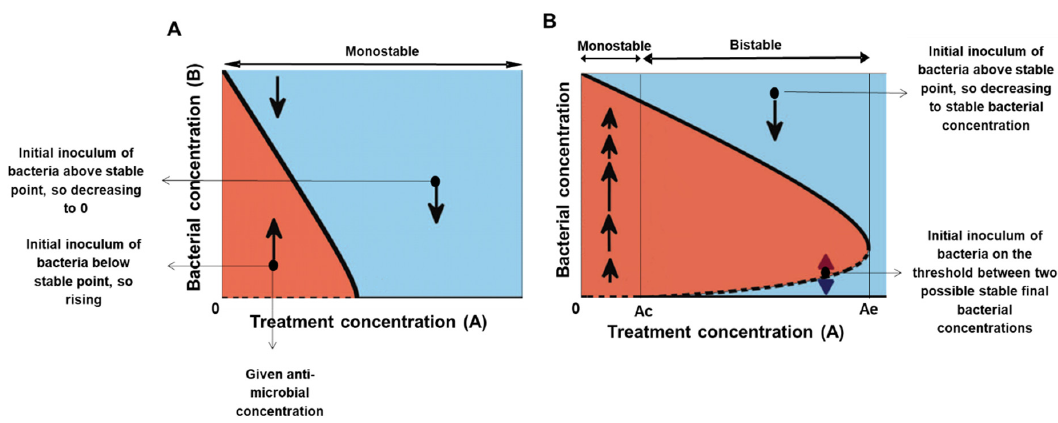
Figure 1. One dimensional models of monostable and bistable bacterial growth in the presence of antimicrobial agents. The x -axis represents the collection of antimicrobial concentrations, the y -axis shows the bacterial amount. In this plot, the bacterial dynamics correspond to motion along vertical lines—from any initial inoculum at a given antimicrobial concentration, the bacterial load increases (moves upward) in the red regions and decreases (moves downward) in the blue regions. The solid/dashed lines correspond to stable/unstable equilibrium states, respectively. ( A ) The monostable model has a single stable equilibrium bacterial concentration for any antimicrobial concentration (a thick full line). ( B ) The bistable model has a range of concentrations, the bistable range, where the system has at least two possible stable equilibria (two full lines). The upper solid line represents the antimicrobial-concentration dependent maximal capacities. The dashed line of unstable equilibria represents the collection of critical bacterial loads B c ( A ) above which the bacteria grow to the upper equilibrium branch and below which the bacteria become extinct or inhibited. A c is a minimal antimicrobial agent concentration that inhibits/kills a minute number of cells. A e is a concentration that inhibits/kills every tested bacterial load. The bistable range corresponds to concentrations between A c and A e